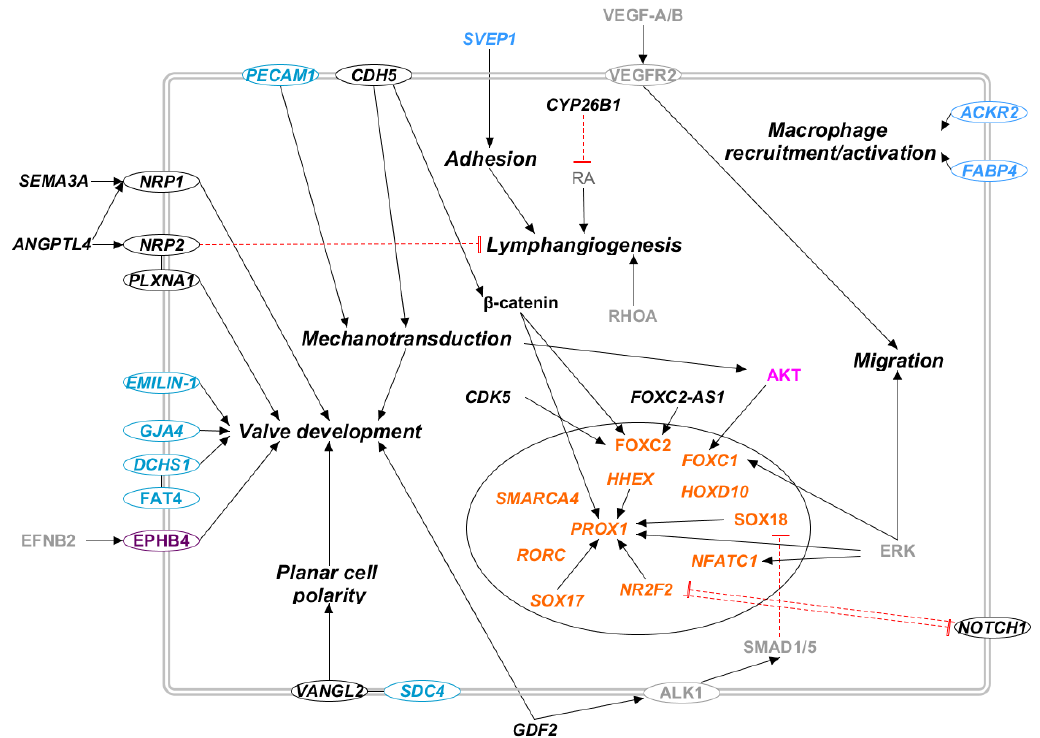
Figure 6. Secondary pathways in candidate genes for primary lymphedema. Proteins that participate in one of the previously reported molecular pathway are colored: RAS/MAPK (violet),